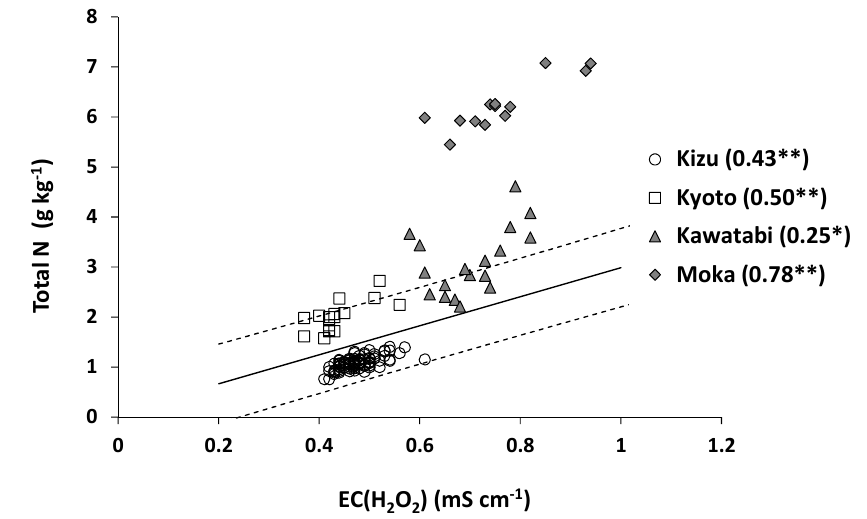
Figure 4. Relationship between EC (H 2 O 2 ) and total N content at farm scale. The solid line in the figure shows the regression line obtained from the nationwide samples excluding volcanic ash soils ( n = 72), and the broken lines indicate the prediction interval at 95% confidence [9]. ** and * indicate statistical significance of the determination coefficients at p < 0.01 and p < 0.05, respectively. Table 4. Slope and y -intercept of the regression lines obtained for the relationship between EC (H 2 O 2 ) and total N content at each farm and at national scale (Figure 4).